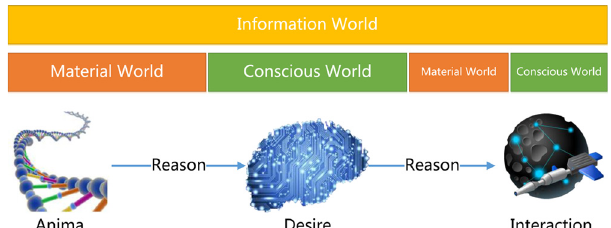
Figure 3. Process of generating spontaneous interaction for the MCIN